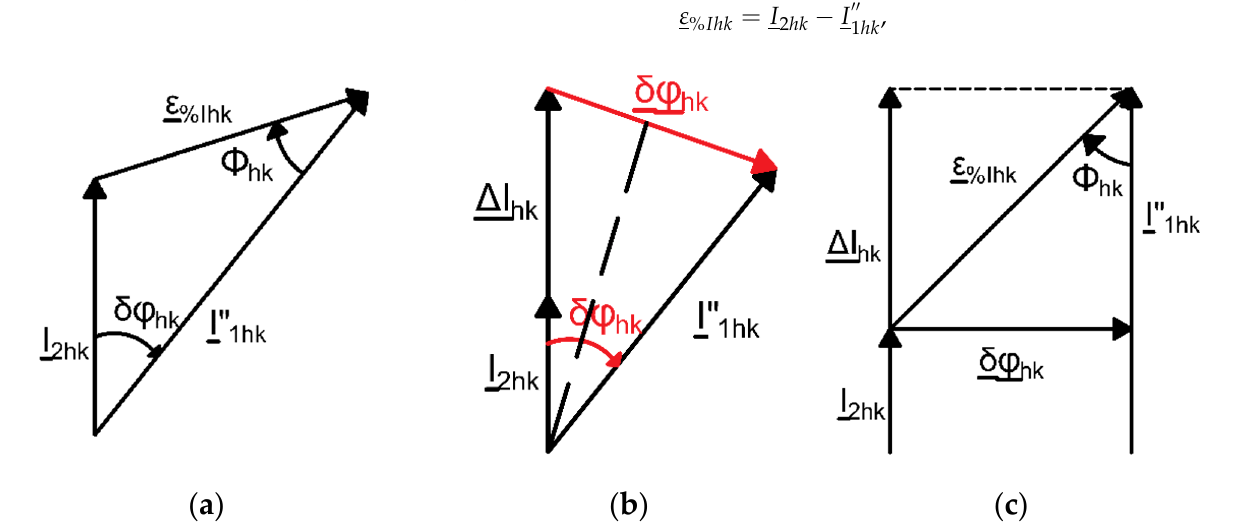
Figure 2. ( a ) Vectorial diagram of the instrument transformer, ( b ) conversion of a low value of the phase angle into a vector of the phase displacement, ( c ) vectorial diagram of the instrument transformer considering performed conversion. ∆ ϕ hk —the value of the phase angle between hk harmonic of the secondary current and hk harmonic of the converted to the secondary side primary current of the current transformer, ϕ hk —the value of the phase angle between hk harmonic of the composite error and hk harmonic of the converted to the secondary side primary current of the current transformer.